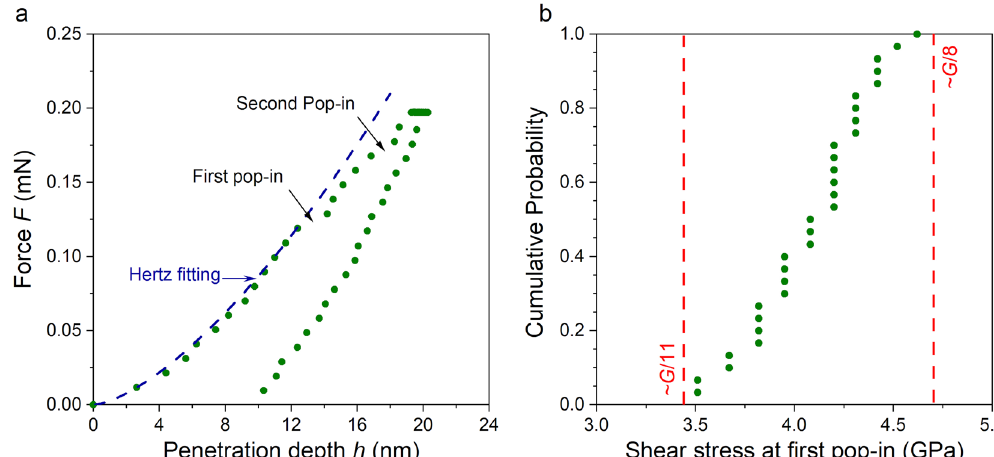
Fig. 1 Assessing the mechanical properties of Pt-BMG with conventional nanoindentation. a Typical force vs penetration depth curve measured on